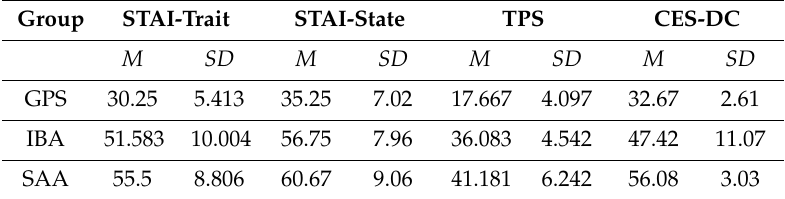
Table 2. Mean scores for STAI-trait, STAI-state, TPS, and CES-DC for the di ff erent groups. Group STAI-Trait STAI-State TPS CES-DC M SD M SD M SD M SD